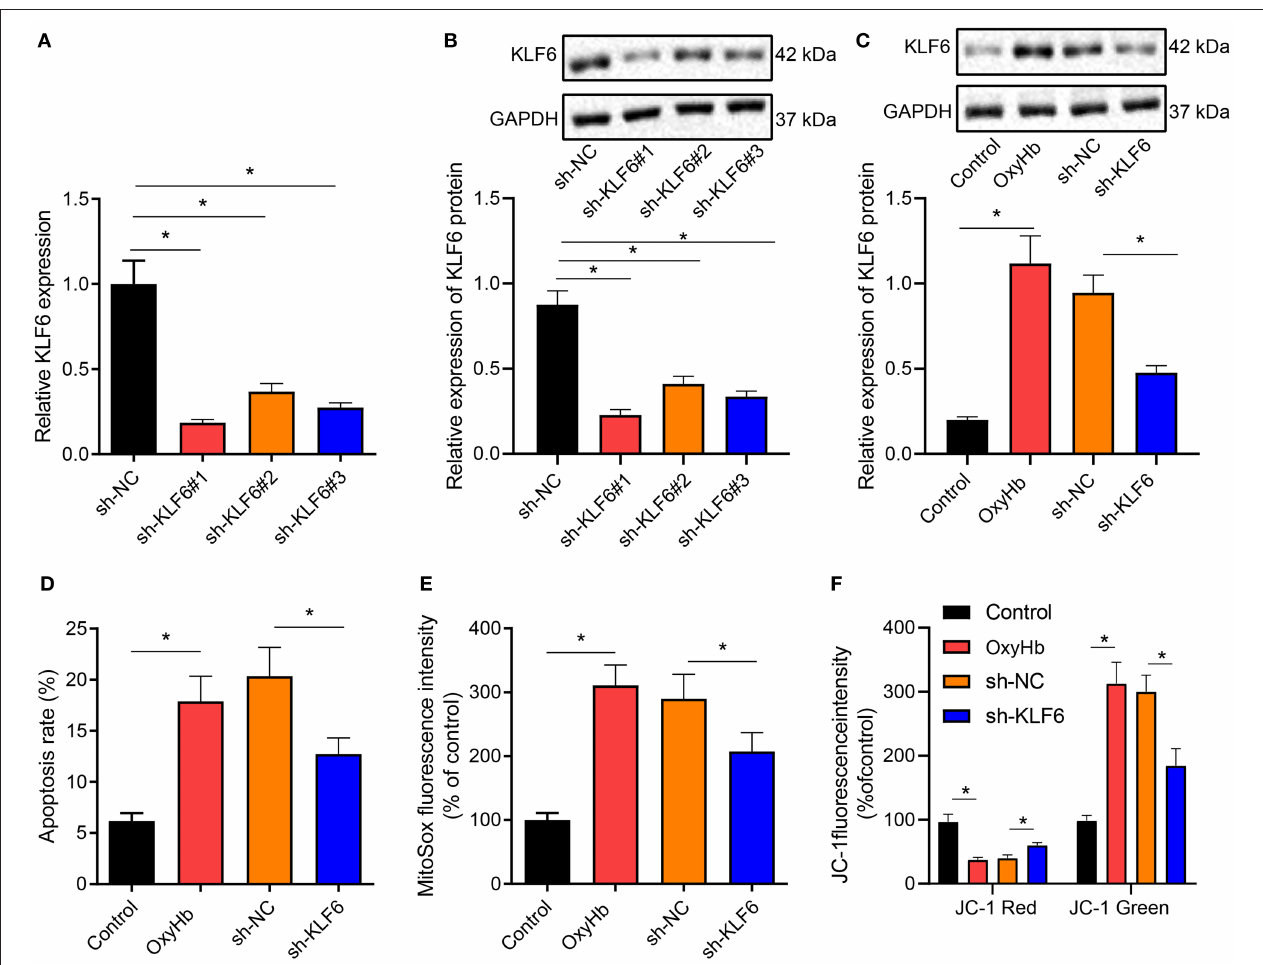
FIGURE 5 | KLF6 silencing depresses OxyHb-induced mitochondrial ROS and mitochondrial damage in hippocampal neurons. (A) The level of KLF6 in hippocampal neurons after KLF6 silencing determined by RT-qPCR. (B) The level of KLF6 in hippocampal neurons after KLF6 silencing determined by Western blot analysis. (C) The expression of KLF6 in hippocampal neurons after 20 µ M OxyHb induction and KLF6 silencing determined by Western blot analysis. (D) The effect of KLF6 silencing on OxyHb-induced hippocampal neuronal apoptosis determined by flow cytometry. (E) The changes of mitochondrial ROS in neurons after 20 µ M OxyHb induction and KLF6 silencing detected by MitoSOX fluorescence staining. (F) Mitochondrial membrane potential changes after 20 µ M OxyHb induction and KLF6 silencing determined by JC-1 staining. * p < 0.05. The measurement data were expressed as mean ± standard deviation. Comparisons between two groups were analyzed using unpaired t -test, and comparisons among multiple groups were tested by one-way ANOVA followed by Dunnett post-hoc test. The experiment was repeated three